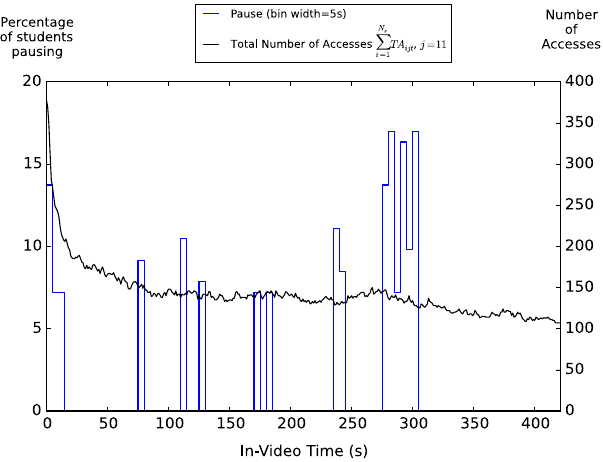
FIG. 7. Clickstream analysis of video 11. This video, entitled “ Newton ’ s second law ” , was accessed by 153 unique students. The black line represents the number of times each particular point of a given video was accessed by students (i.e., the value at P N s j ¼ 11 ). The in-video time t was obtained by i ¼ 1 TA ijt , where blue line represents the percentage of unique students that have ever paused within each 5 s time window. To help identify common pause peaks, only cases for which the percentage of students pausing is greater than or equal to 2 median absolute deviations above the median value of all 5 s windows ( 2 σ þ median, which in this case corresponds to 7.2%) were shown in the figure. Since we are interested in student-generated pauses, automatic pauses that occurred at the very end of the video have been taken out.